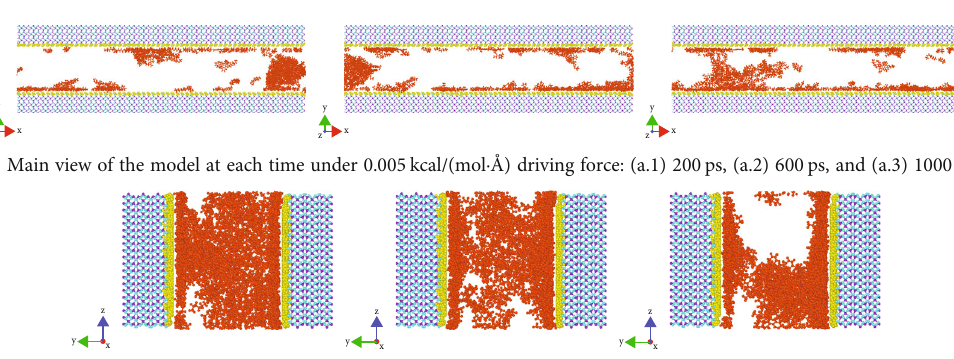
Figure 6: Pictures of the model at each time under 0.003 kcal/(mol · Å) driving force.